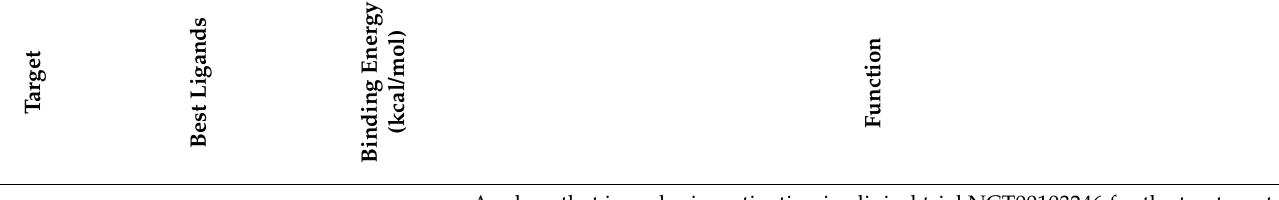
Table 2. Fifteen top-ranking docked compounds and their binding